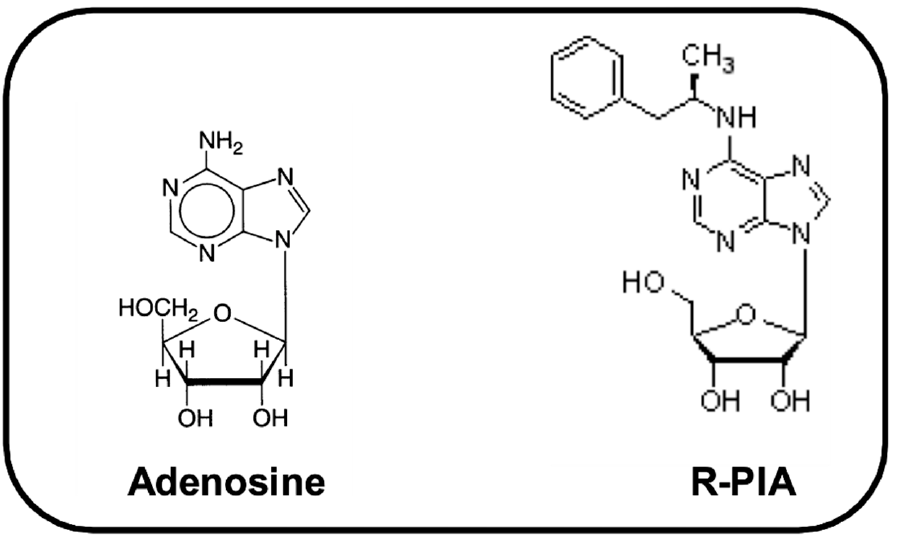
Figure 1. Molecular structure of compounds adenosine: (2 R , 3 R , 4 S , 5 R )-2-(6-amino-9 H -purin-9-yl) 5-(hydroxymethyl)oxolane-3,4-diol, and its A1 agonist R-PIA: [R-N6-(2-phenylisopropyladeno- sine)].